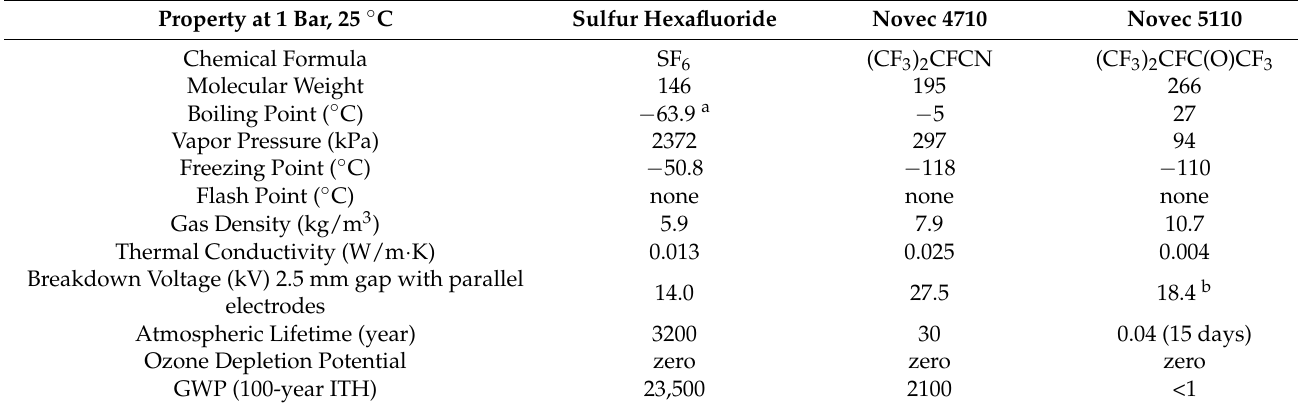
Table 1. Alternative gas properties compared to SF 6